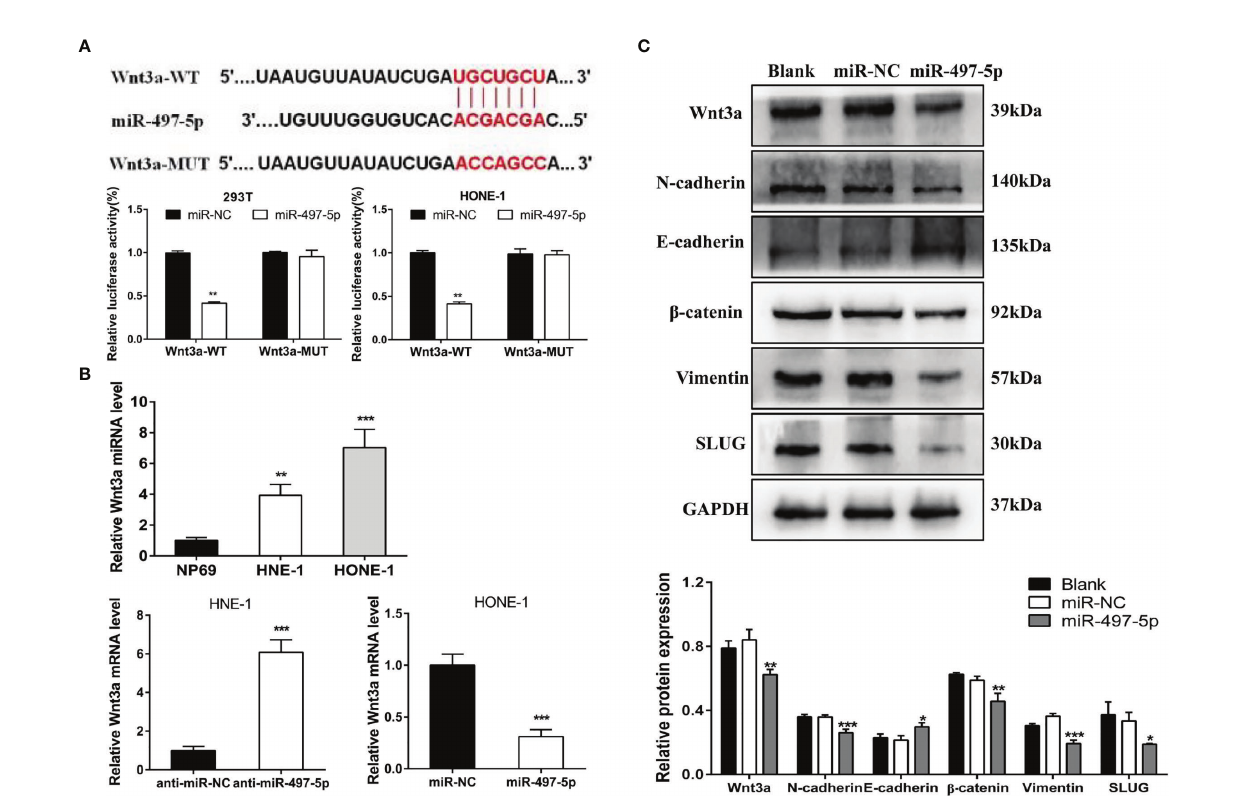
FIGURE 6 | miR-497-5p affected the wnt3a/ b -catenin pathway. (A) The binding sites of Wnt3a and miR-497-5p were predicted through bioinformatics analysis and con fi rmed by dual-luciferase reporter gene assay. (B) Wnt3a expression was increased and negatively associated with miR-497-5p in NPC cells. (C) Overexpression of miR-497-5p led to a signi fi cant inhibition of Wnt3a/ b -catenin signaling pathway. *P < 0.05, **P < 0.01, ***P <